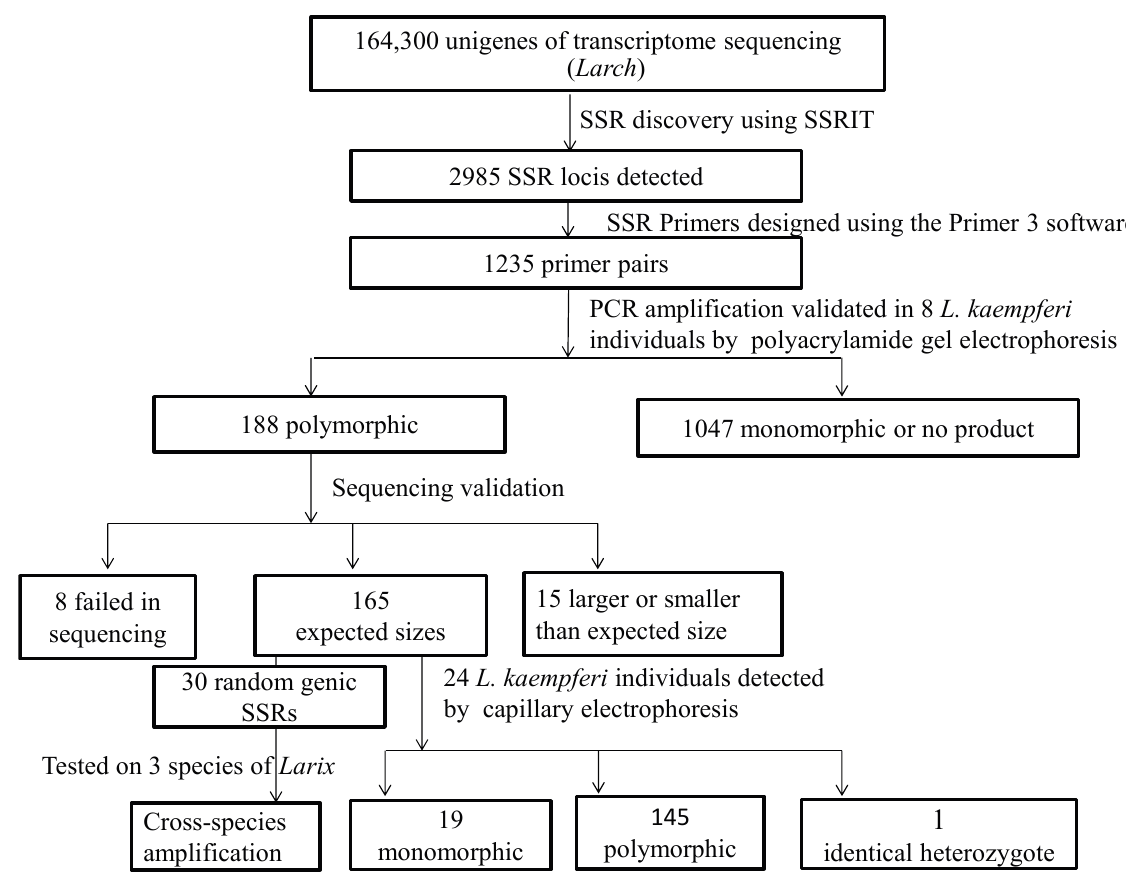
Figure 1. Flow diagram of L. kaempferi genic-SSRs development and applications in this study. Using eight individuals of L. kaempferi , 188 (15.2%) of 1235 primer pairs were identified